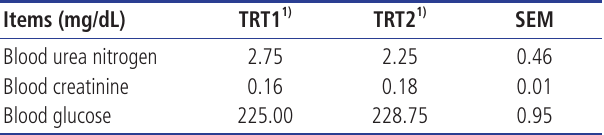
Table 7. Effect of GMO and non-GMO corn-SBM diets on blood profile of